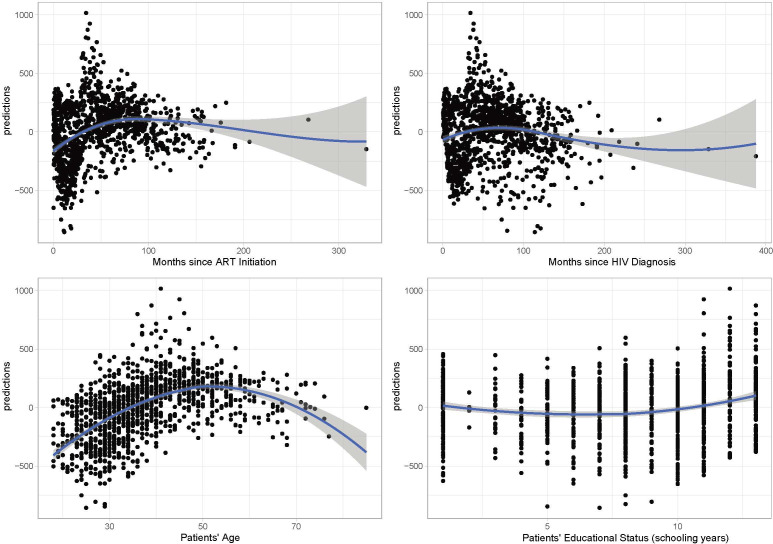
Heterogeneity plots for household expenditures.